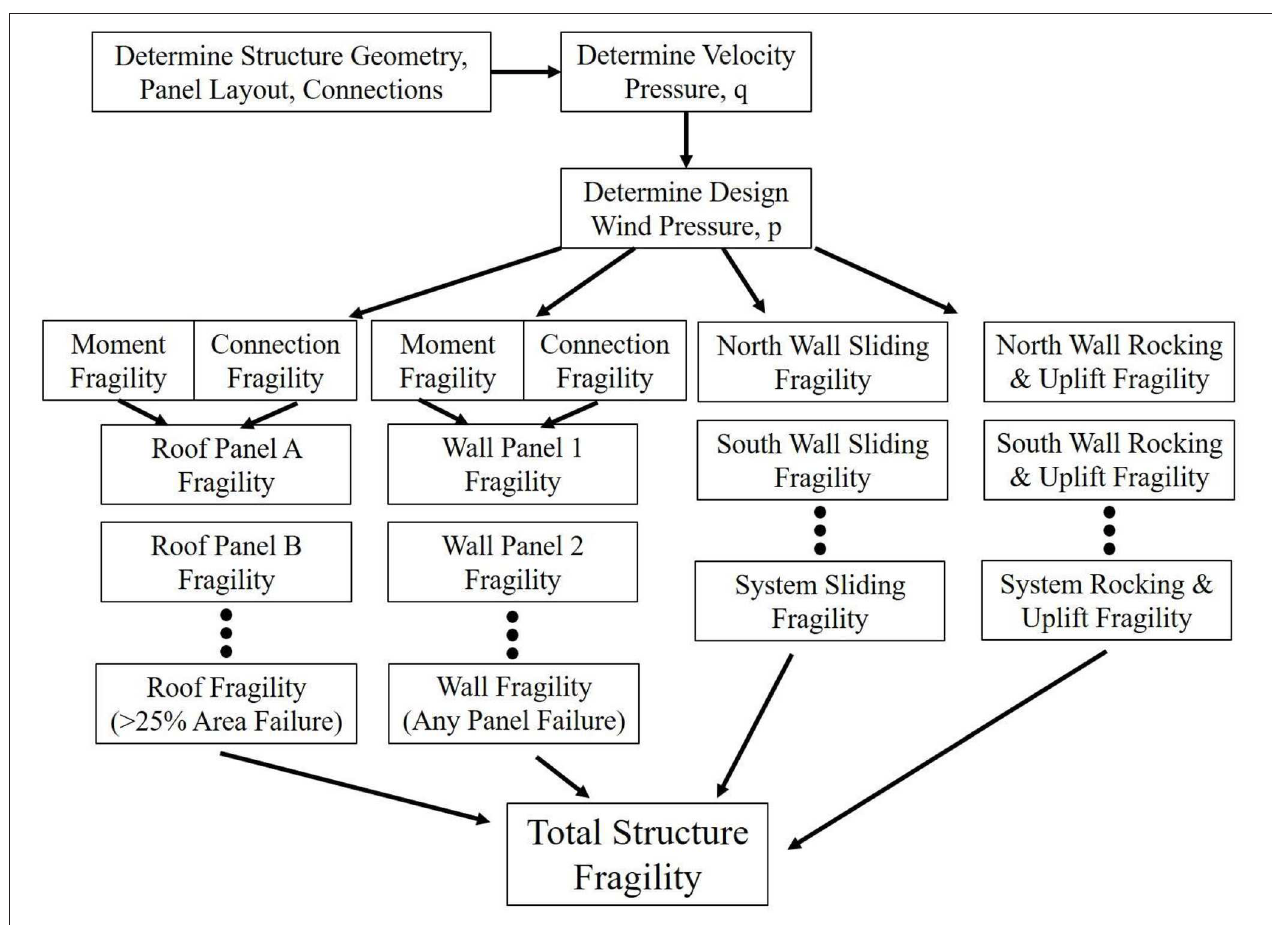
FIGURE 5 | Framework for development of fragility